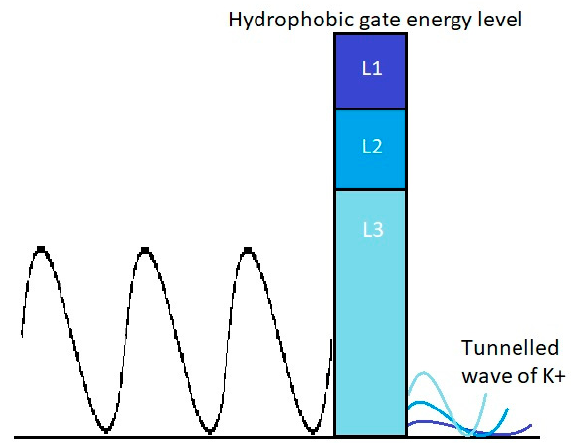
Figure 3. E ff ect of channelopathy on free gating energy and potassium ion quantum Figure 3. Effect of channelopathy on free gating energy and potassium ion quantum tunneling.